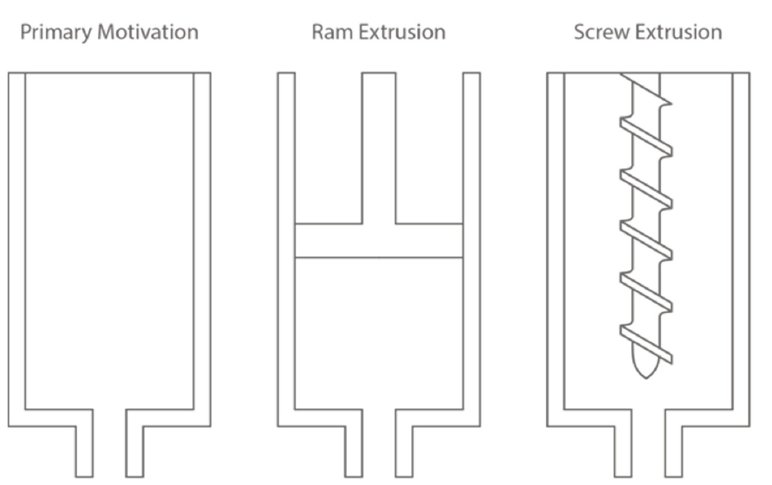
Figure 3. The schematic sketches of extruder mechanisms: primary motivation, ram extrusion and screw extrusion. Table 2. The effects of extruder mechanisms on the extrusion forces, extrusion behaviors, extruda- bility and economic aspects and technical complexity based on the same material design and oper- ational design.